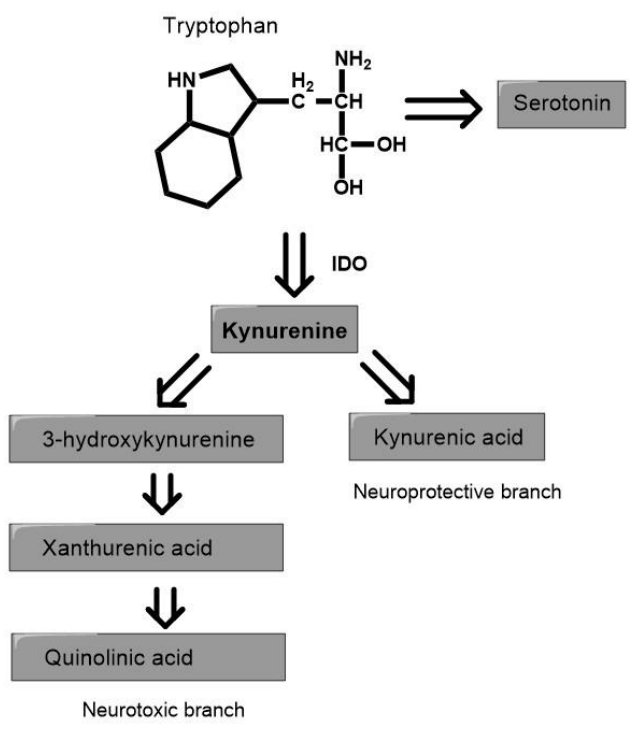
Figure 1. The simplified diagram of the pathways of tryptophan metabolism. IDO—indoleamine 2,3-dioxygenase.